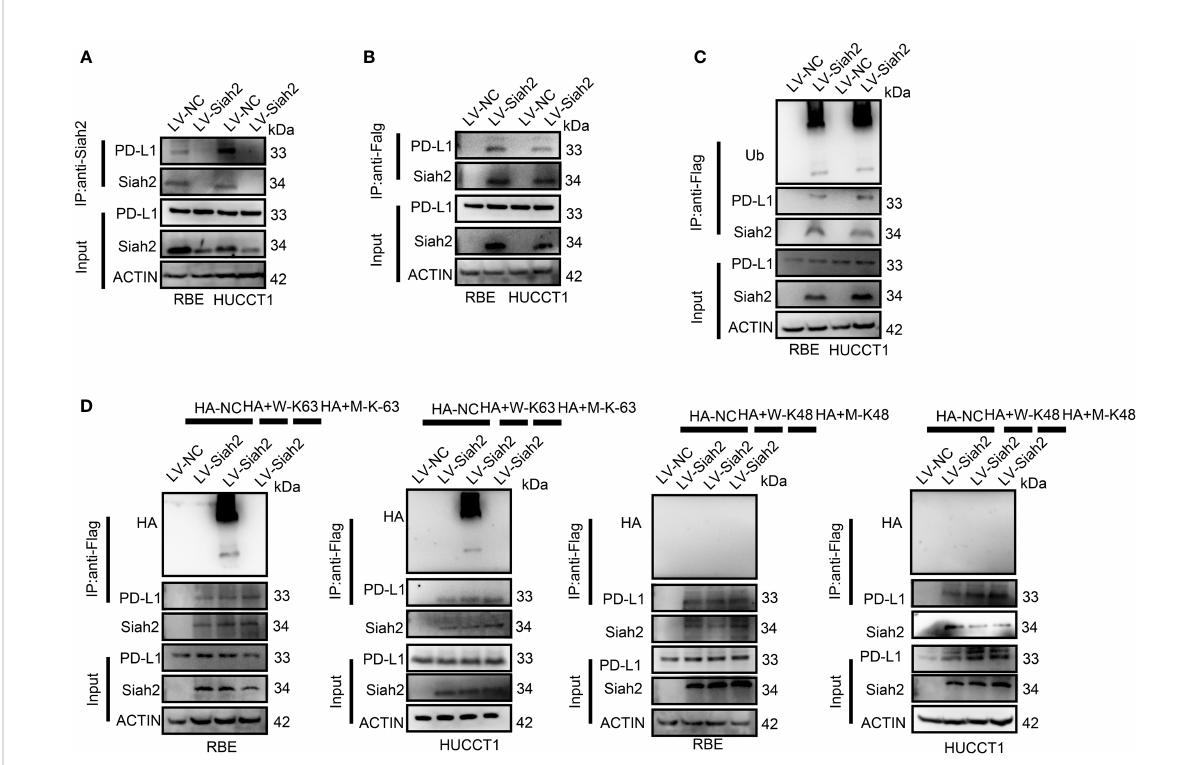
FIGURE 4 Siah2 physically interacts with PD-L1 and increases the K63-linked ubiquitination of PD-L1 in CCA. (A) , CCA cells were transfected with HA- Siah2 and Flag-PD-L1 for 36 h. Immunoprecipitation was performed with anti-Siah2 and analyzed by immunoblotting. (B) , CCA cells were transfected with HA-Siah2 and Flag-PD-L1 for 36 h. Immunoprecipitation was performed with anti-HA and analyzed by immunoblotting. (C) , CCA cells with LV-NC/LV-Siah2 were treated with MG132 for 8 h before harvesting, after which cells were harvested in lysis buffer. Supernatants were incubated with the appropriate antibodies overnight. Ubiquitin-modi fi ed proteins were analyzed with anti-Ub antibodies. (D) , CCA cells with LV-NC/LV-Siah2 were treated with MG132 for 8 h before harvesting, after which cells were harvested in lysis buffer. Supernatants were incubated with the appropriate antibodies overnight. Ubiquitin-modi fi ed proteins were analyzed with anti-lysine 48(K48) – linked polyubiquitination or K63-linked